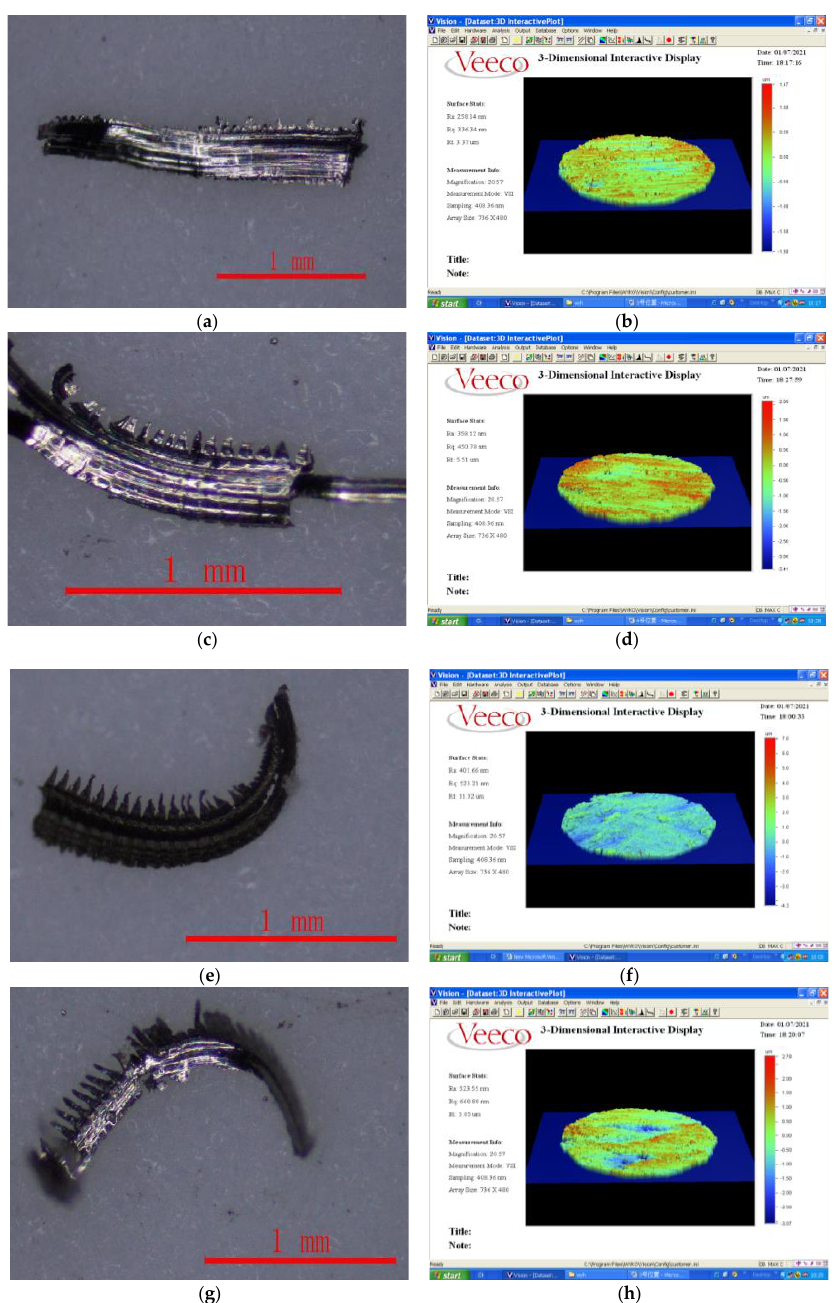
Figure 10. The shape of chips and roughness of surface. ( a ) Chip topography (Cutting force is 280 N). ( b ) Three-dimensional surface topography. ( c ) Chip topography (Cutting force is 400 N). ( d ) Three-dimensional surface topography. ( e ) Chip topography (Cutting force is 470 N). ( f ) Three-dimensional surface topography. ( g ) Chip topography (Cutting force is 620 N). ( h ) Three-dimensional surface topography.